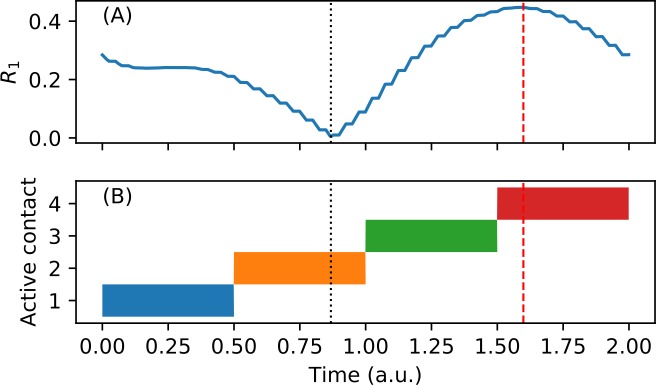
Optimal time to turn off stimulation depends on the magnitude of the first order parameter at that time.(A) First order parameter during one CR period (T = 2) in the desynchronization state regime (I = 7, σ = 2), after reaching steady-state. Optimal toff occurs when R1 is minimal, indicated by dotted black vertical line. Converseley, pessimal toff occurs when R1 is maximal, indicated by dashed red line. (B) Periodic CRS pattern that induces the time-varying order parameter shown in A. Optimal toff occurs at a fixed point within the stimulation site activation pattern. In this example, it is always approximately 0.38 time units after the activation of the second stimulation site.